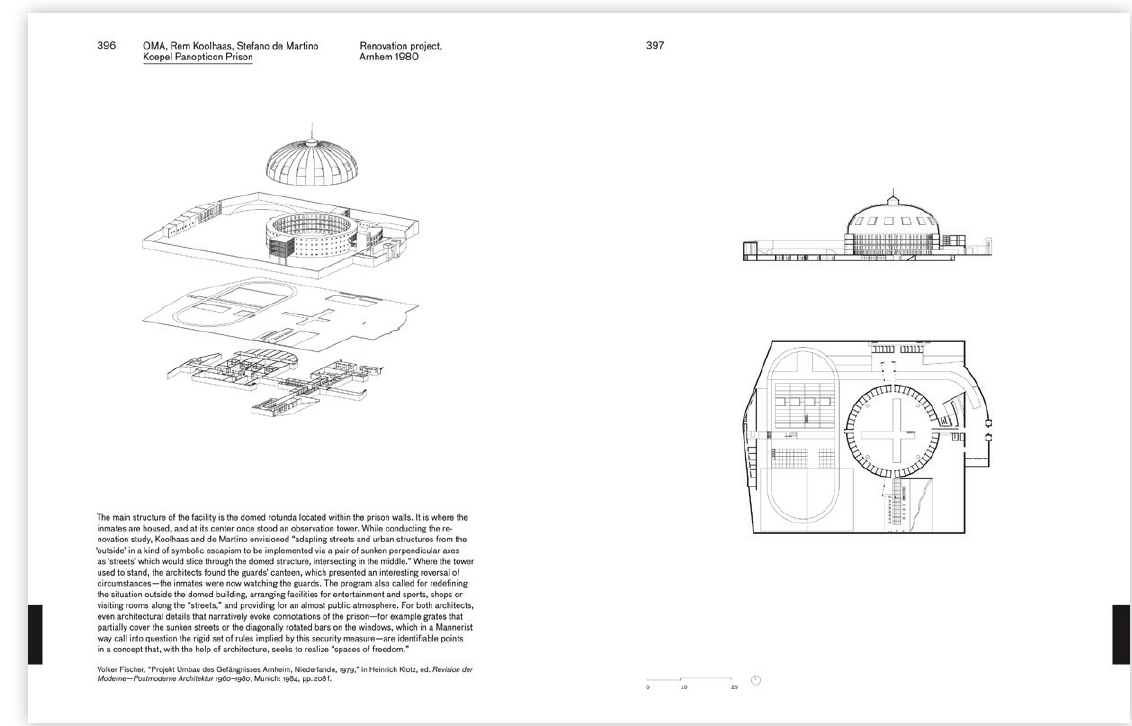
Figure 3. Page spread for OMA Koeppel project. Acknowledgement: Park Books and Andreas